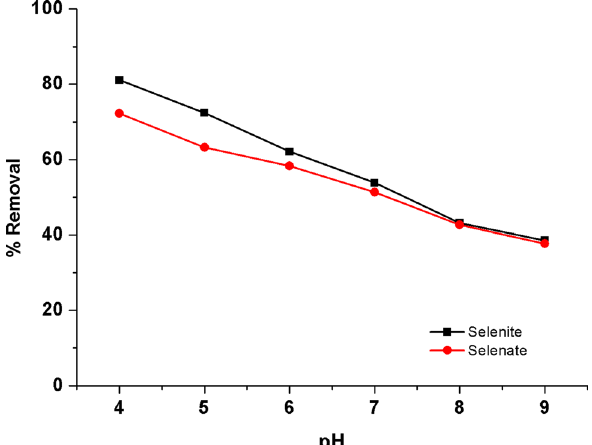
Fig. 6 Effect of pH on selenite and selenate adsorption by MAA (batch volume 100 ml, temperature 30 ± 2 °C, initial Se concentration 200 µg L −1 , contact time 12 h, adsorbent dose 0.5 g L −1 for selenite and 2.0 g L −1 for